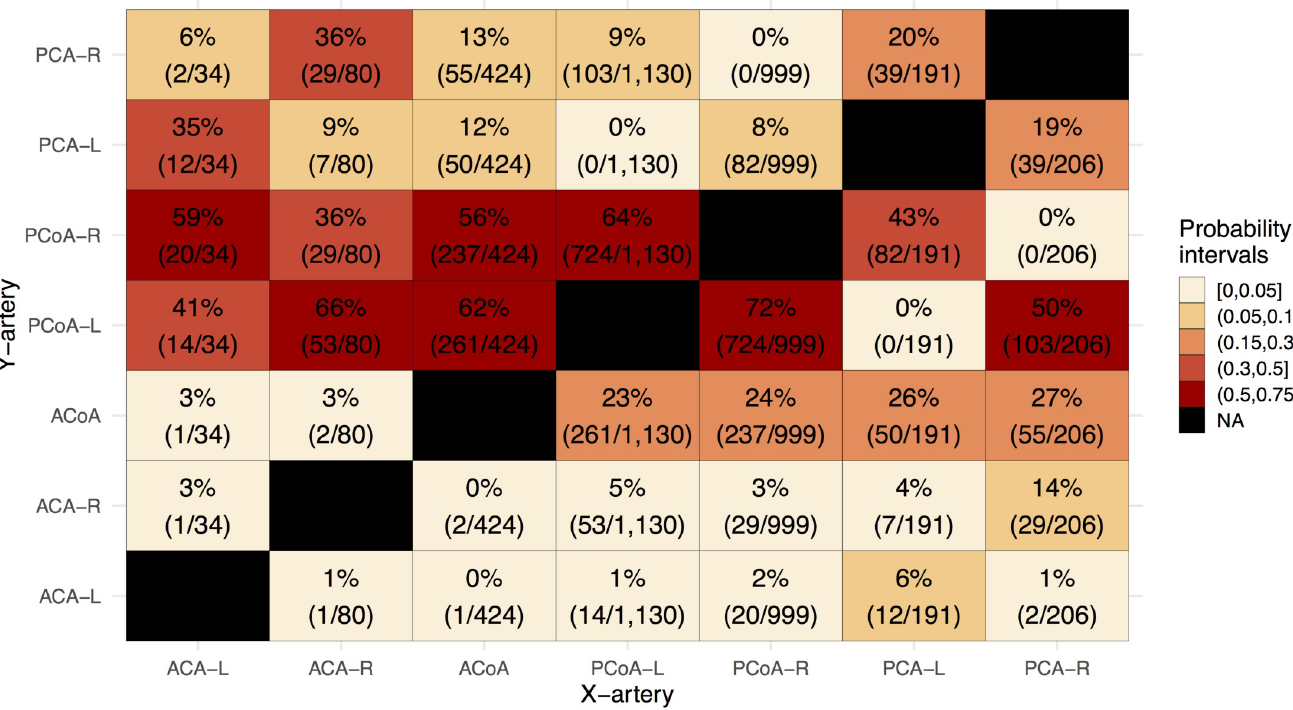
Fig 5. Heatmap of conditional probabilities that Y-artery is missing given that X-artery was missing. Numerators and denominators of conditional probability estimates are provided in the brackets, and represent respectively the number of times two segments are missing at the same time (joint probability) and per column the number of times the artery X is missing (independent probability). The common denominator of the joint probabilities and independent probabilities have cancelled. ACA: Anterior cerebral artery. ACoA: Anterior communicating artery. PCoA: Posterior communicating artery. PCA: Posterior cerebral artery. Left and right lateralization are denoted by “L” and “R” respectively. Each successive heatmap interval increases in size with 0.05.